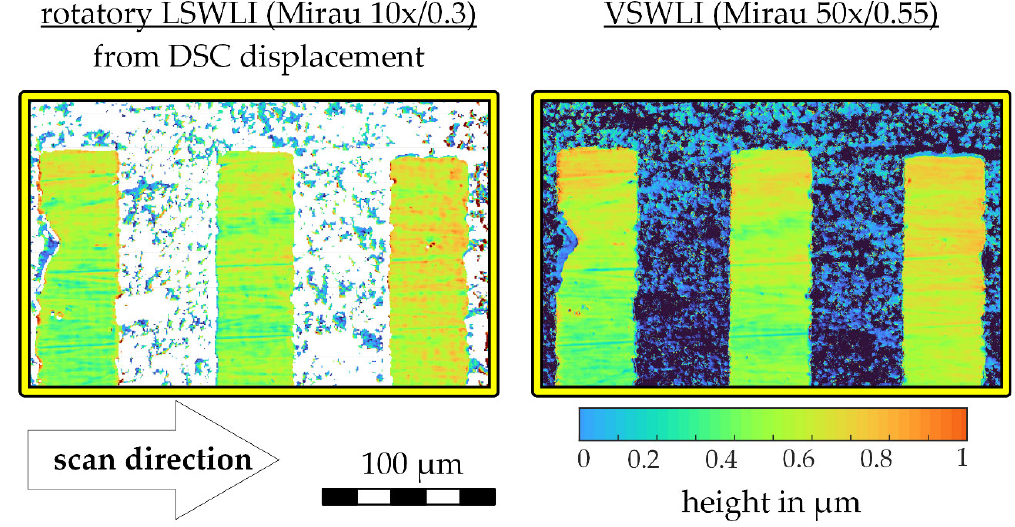
Figure 6. Results of topography measurements. Left : topography detail calculated using DSC displacements. Right : topography detail obtained from VSWLI reference measurement.